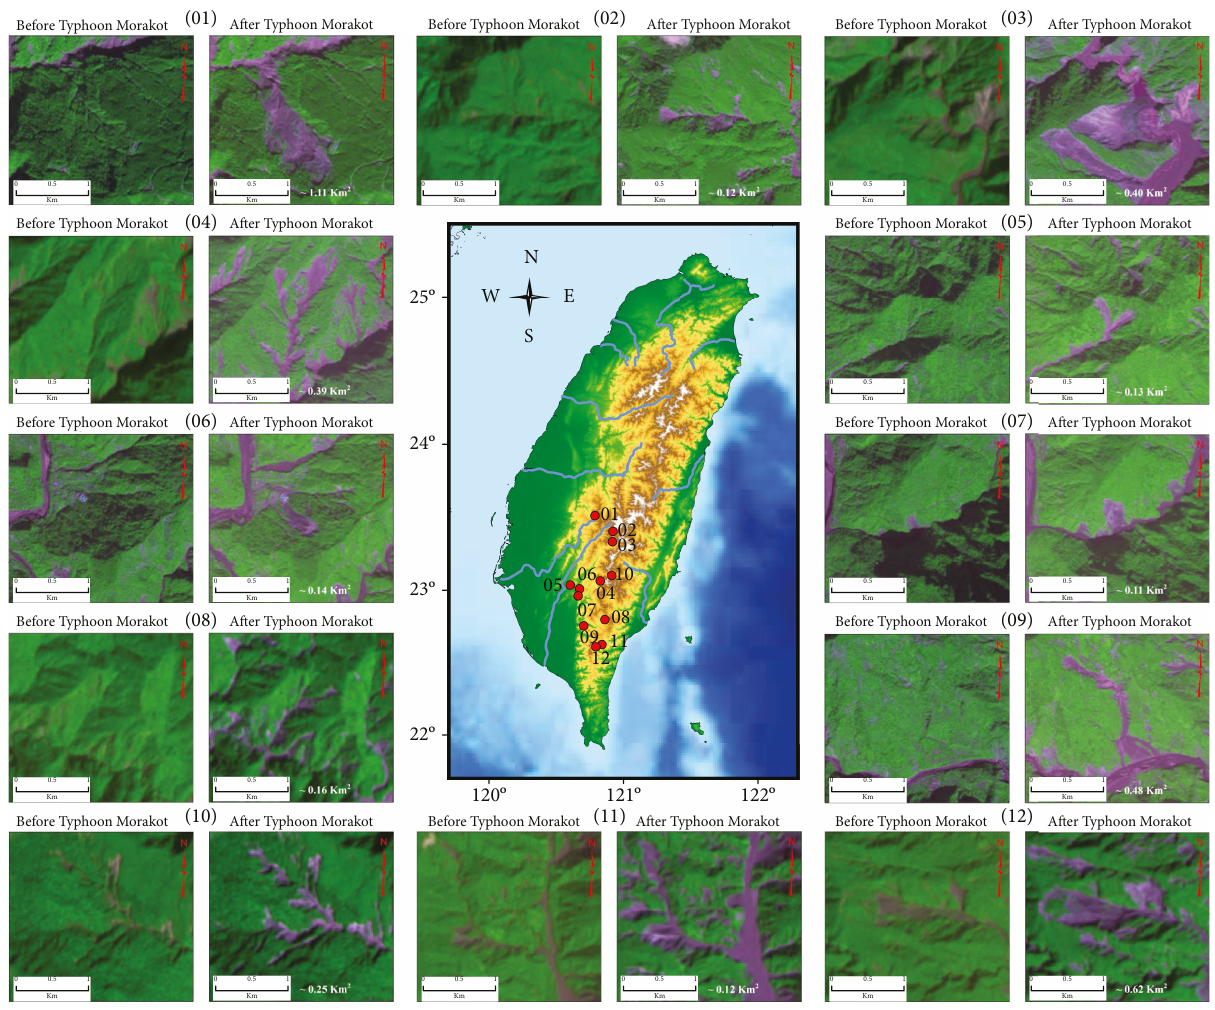
Figure 9: Examples of landslides that occurred during the 2009 Typhoon Morakot detected based upon our algorithm and con fi rmed by satellite